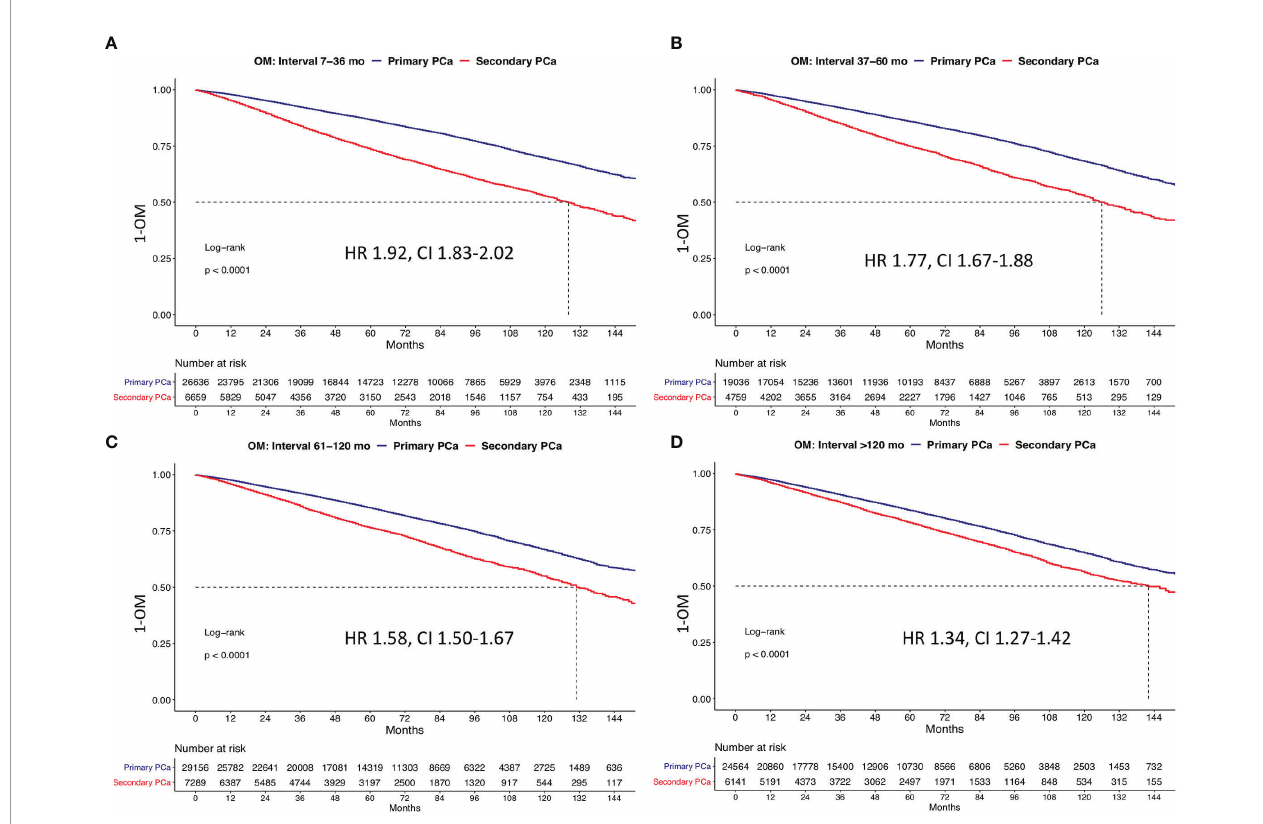
FIGURE 5 | Kaplan Meier plots depicting overall mortality (OM) for primary and secondary prostate cancer according to the time interval between primary cancer and secondary prostate cancer at (A) 7 – 46 months, (B) 37 – 60 months, (C) 61 – 120 months, and (D) >120 months. HR, hazard ratio; CI, con fi dence